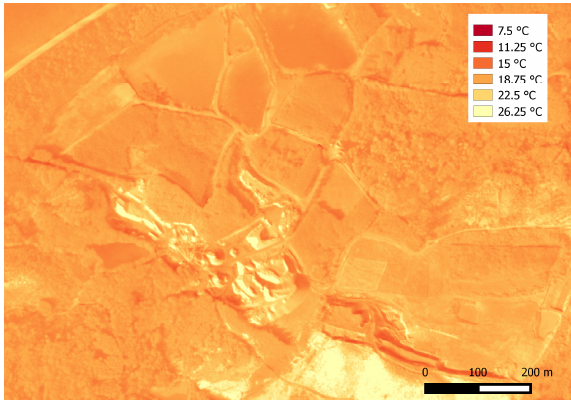
Figure 4. Magnification of the TIR image to show the stone pit in more detail.